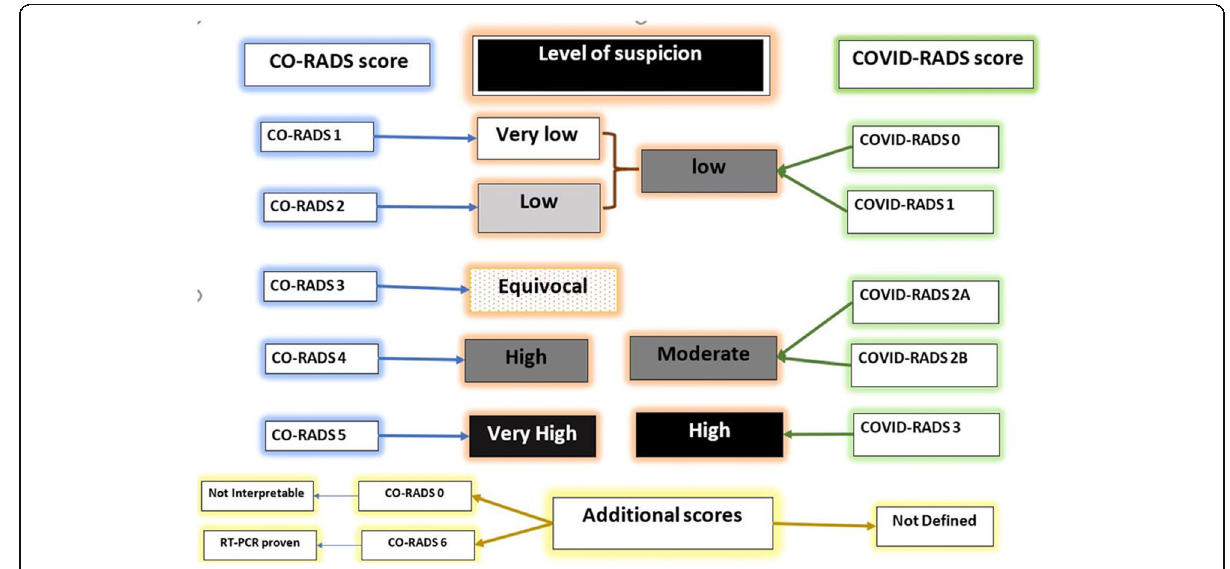
Fig. 2 Different levels of COVID-19 suspicion and correspondent score in both